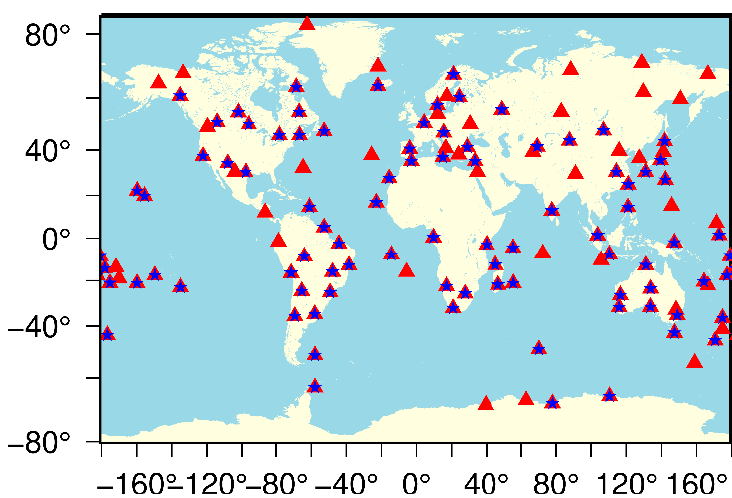
Figure 2. Distribution of GNSS-tracking stations . Red triangles denote stations used for GNSS precise orbit determination and blue pentagrams denote stations used for GNSS ultra-rapid orbit determination.